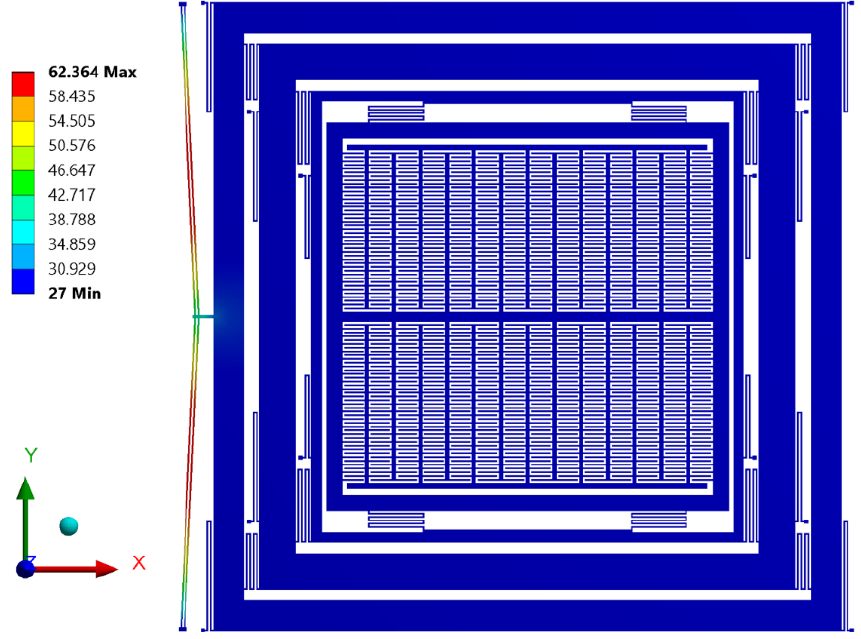
Figure 16. Temperature profile in the proposed MEMS gyroscope.